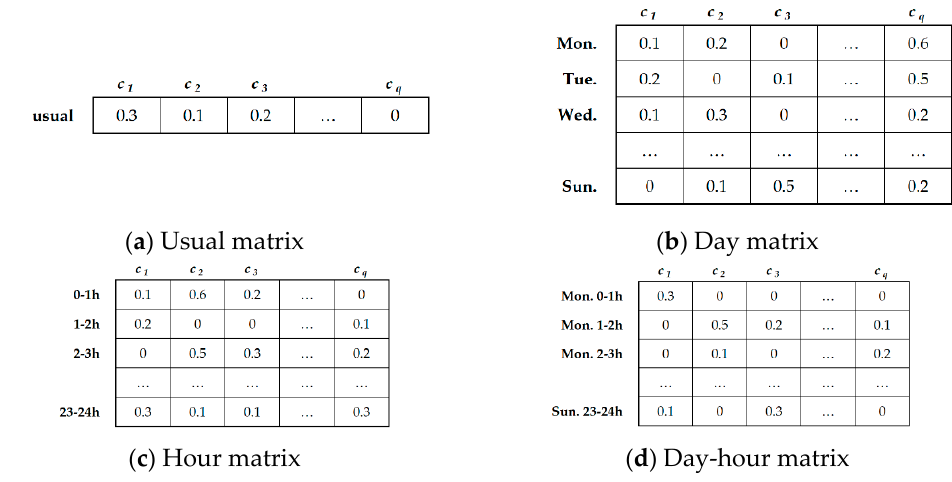
Figure 1. An example of a user’s time-aware channel preferences: ( a ) usual matrix composed of only channels, ( b ) day matrix composed of channels and days, ( c ) hour matrix composed of channels and hours, and ( d ) day-hour matrix composed of channels and days-hours.